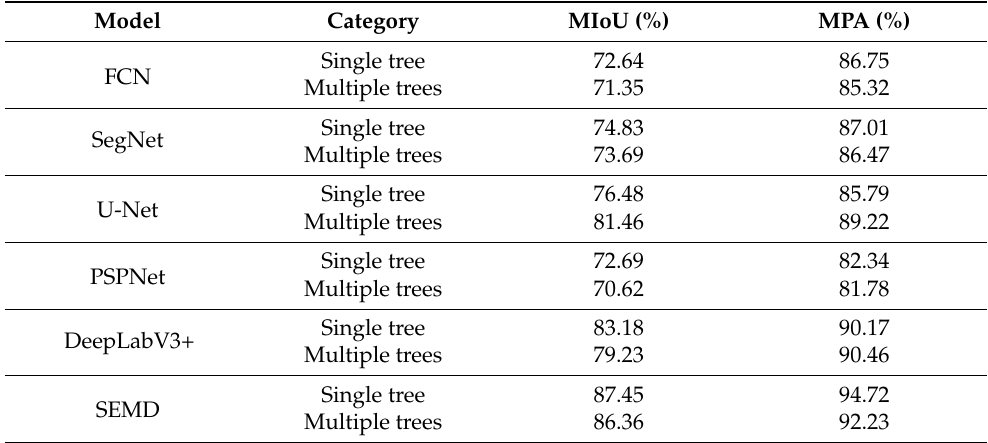
Table 6. Performance comparison under complex background.